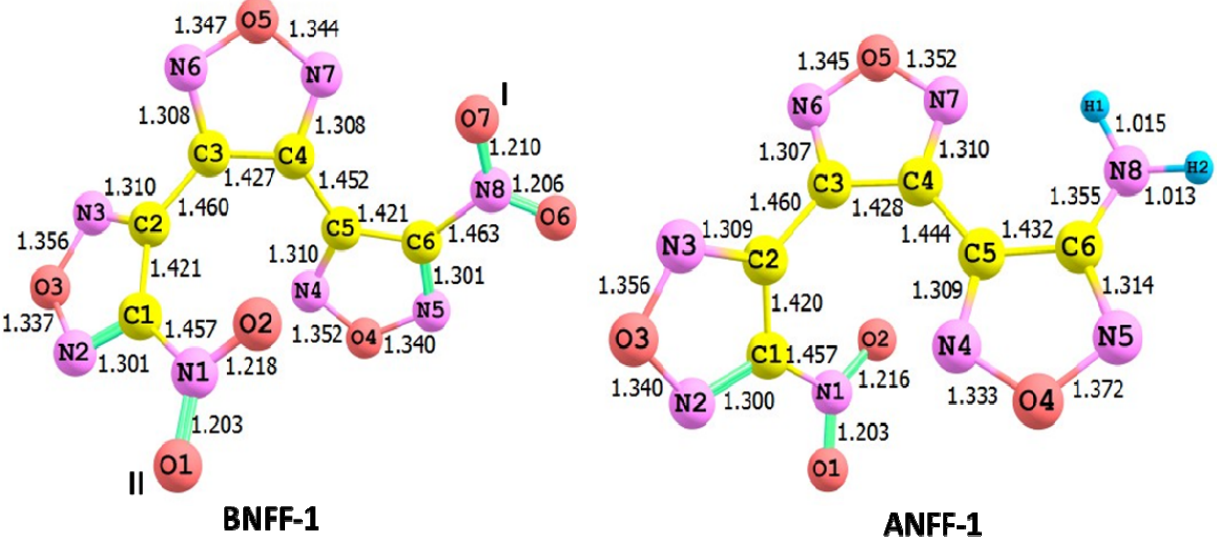
Figure 2. The geometry structures of BNFF-1 and ANFF-1. The non-equivalent nitro- groups in BNFF-1 are denoted with (I) and (II). The nitro-group (I) is substituted with an amino-group to form ANFF-1. The shown bond distances (Å) correspond to the M06 level of